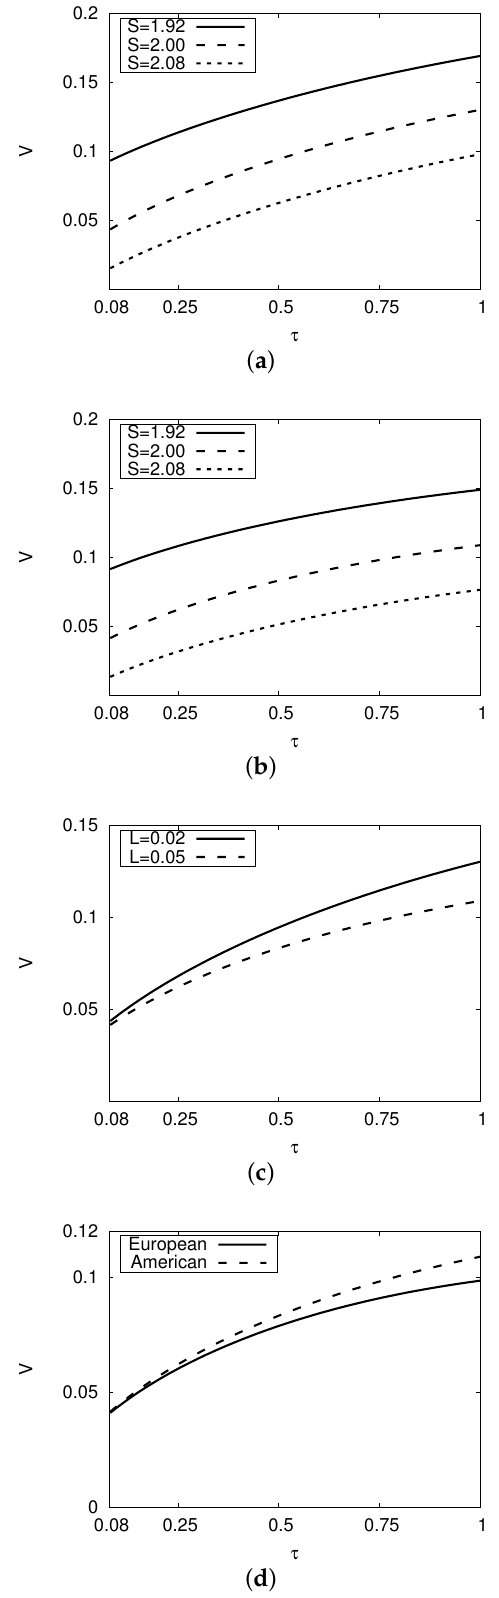
Figure 4. ( a ) American CI put ( V ) values with L = 0.02, ( b ) American CI put ( V ) values with L = 0.05, ( c ) American CI put ( V ) values with S = 2 and ( d ) European and American CI put ( V ) values with L = 0.05 for various expiries ( τ ). Parameters used: r = 0.05, q = 0.04, σ = 0.2, X =